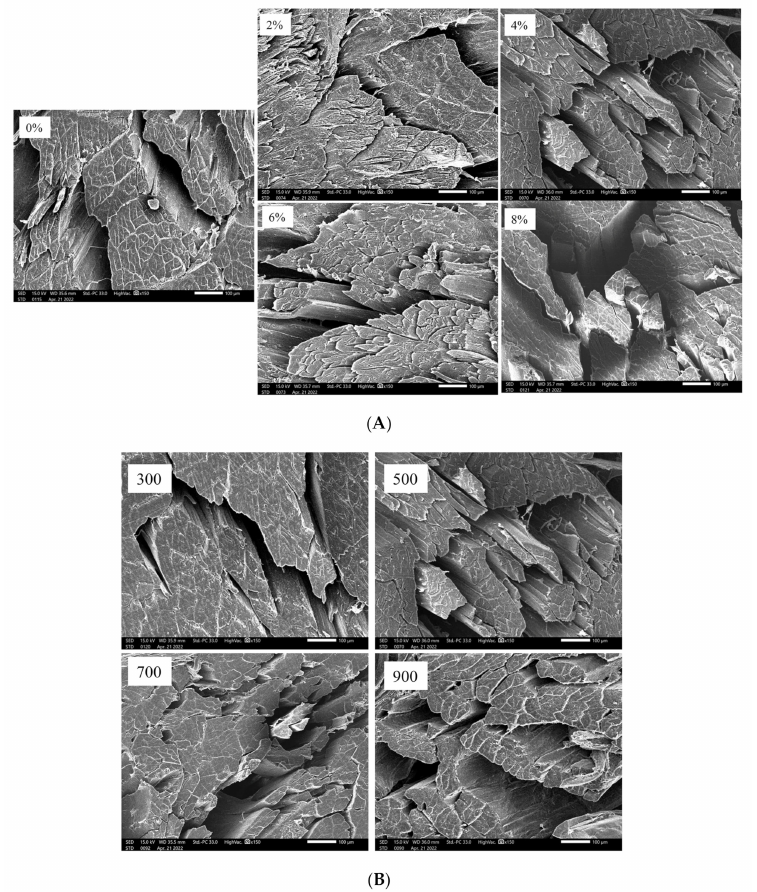
Figure 8. Effect of different salt concentrations on the microstructure of dried shrimps (500 × ) at a fixed MW of 500 W ( A ); the effect of different microwave powers on the microstructure of dried shrimp (500 × ) at a fixed salt concentration of 4% ( B